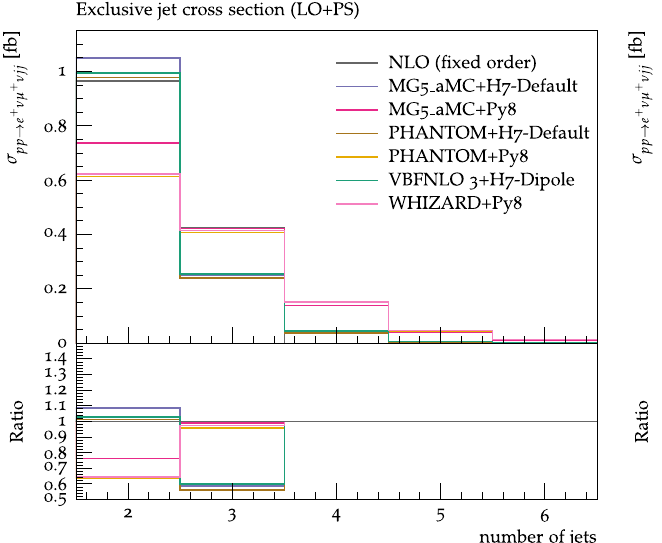
Fig. 13 Differential distribution in the exclusive jet multiplicity from predictions matched to parton showers, at LO (left) or NLO (right) accuracy (upper plot), compared with the fixed-NLO result computed with VBFNLO (lower plot). At NLO+PS accuracy, for VBFNLO + Herwig7- Dipole , the three-point scale uncertainties are